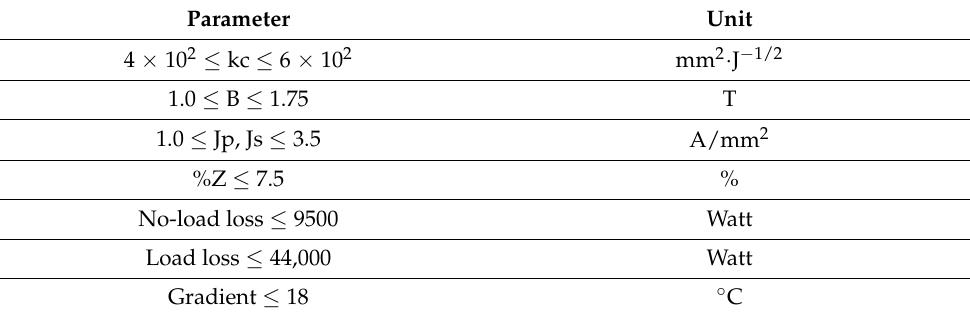
Table 1. Parameter design